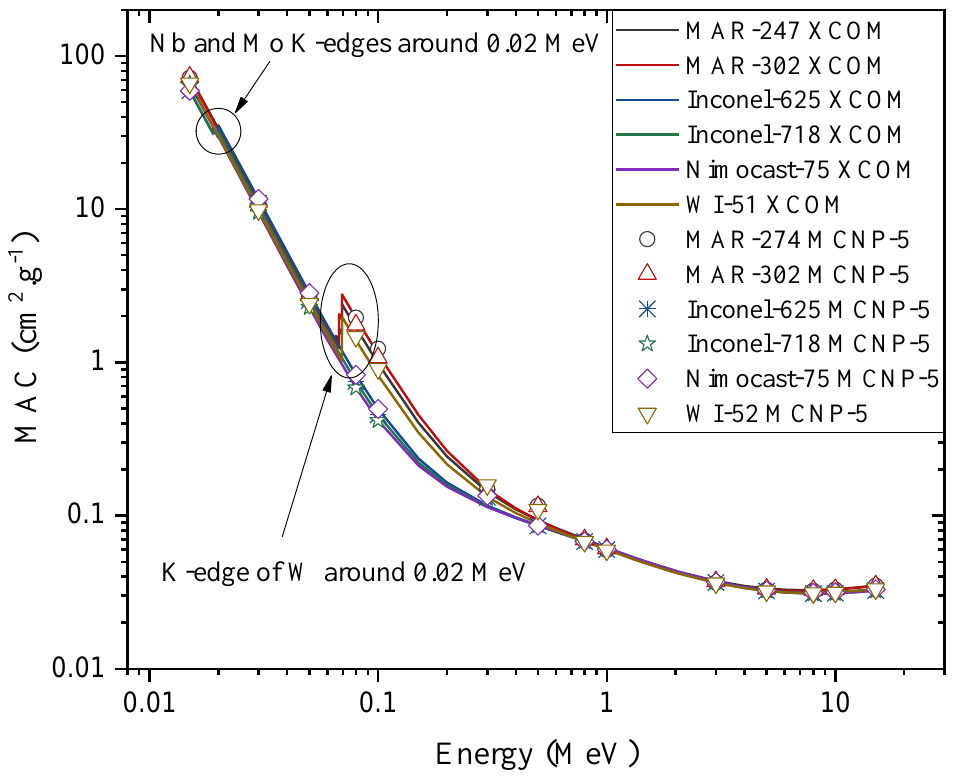
Figure 2. The mass attenuation coefficient (MAC) of the studied alloys using the MCNP-5 code and XCOM software.